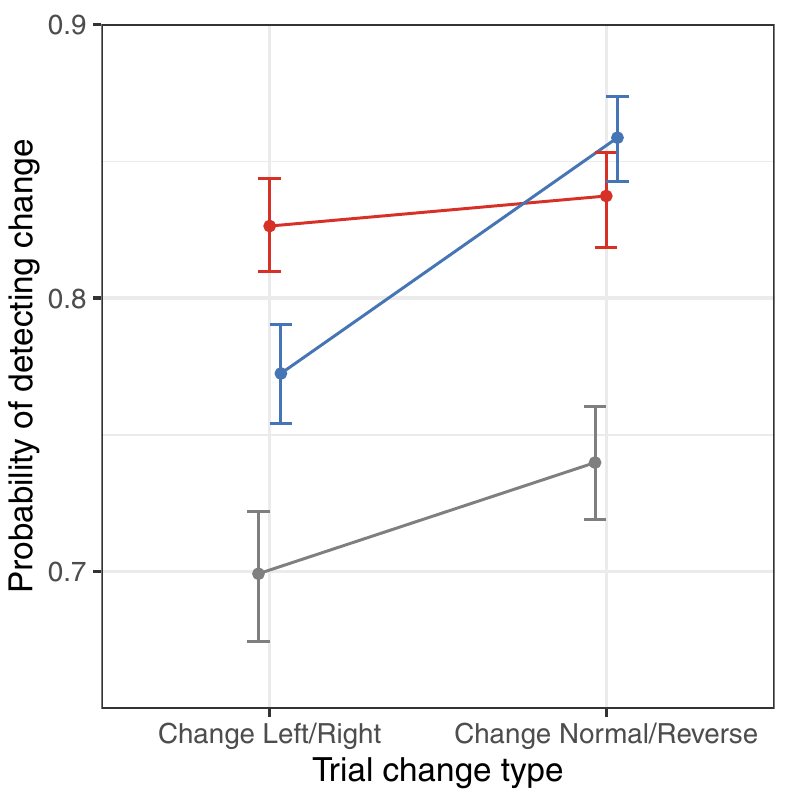
Figure 5. Performance on change trials that cross category boundaries, as a function of boundary type and experimental training condition. We predicted that change detection performance would be highest when the visual change corresponded to a known categorical distinction. Error bars correspond to 95% highest density credible intervals (HDCI) around the mean. Values in parentheses indicate the 95% HDCI for the difference between conditions. (Figure generated using R version